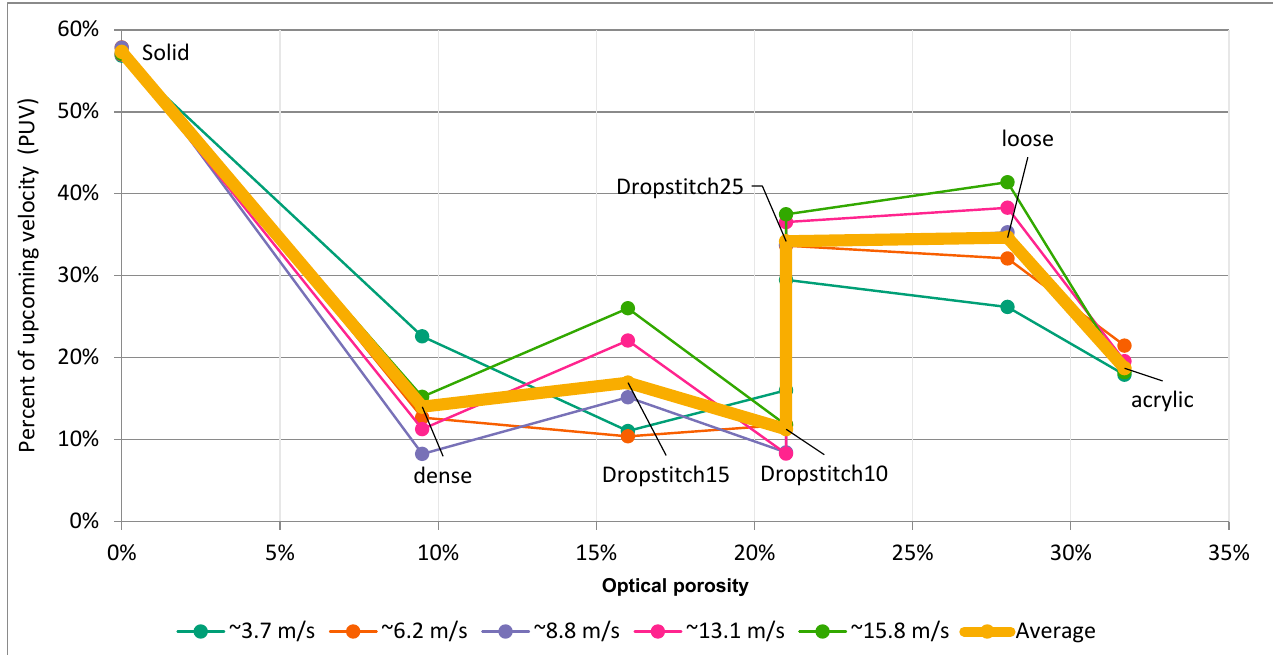
Figure 14. Percentage of upcoming velocity (PUV) depending on the calculated optical porosity.